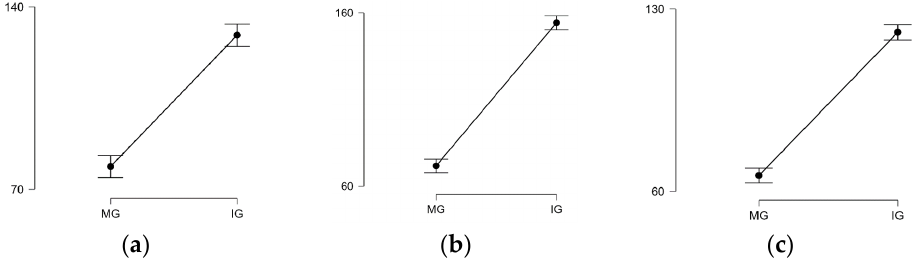
Figure 6. Descriptive plots MG—IG. ( a ) Pekkton; ( b ) Juvora; ( c ) BioHPP.